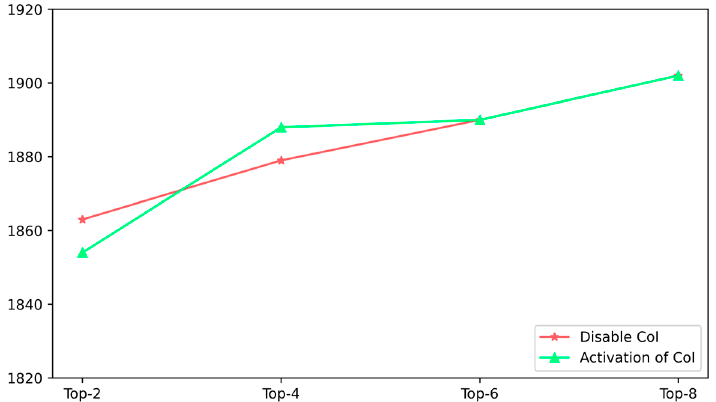
Figure 9. Efficiency performance comparison of deactivated CoI and activated CoI.